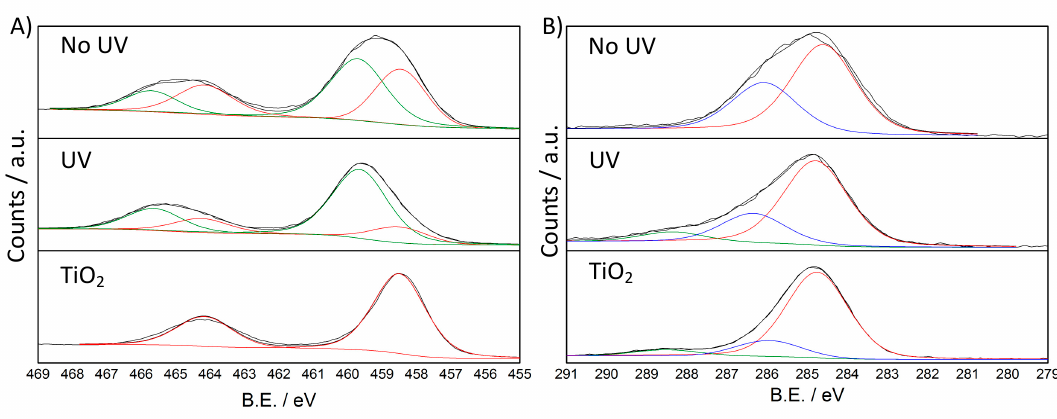
Figure 7. High resolution XPS spectra, and relative fitting, of NoUV, UV and TiO 2 samples: ( A ) Ti 2p region and ( B ) C 1s region. Table 2. B.E. and peak area of the components of the UV and NoUV samples compared to pristine TiO 2 .